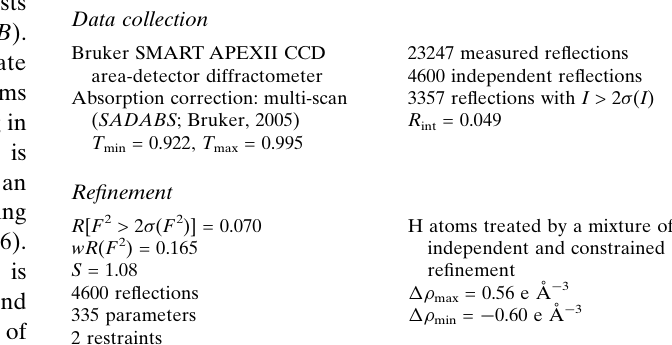
Data collection Bruker SMART APEXII CCD area-detector diffractometer